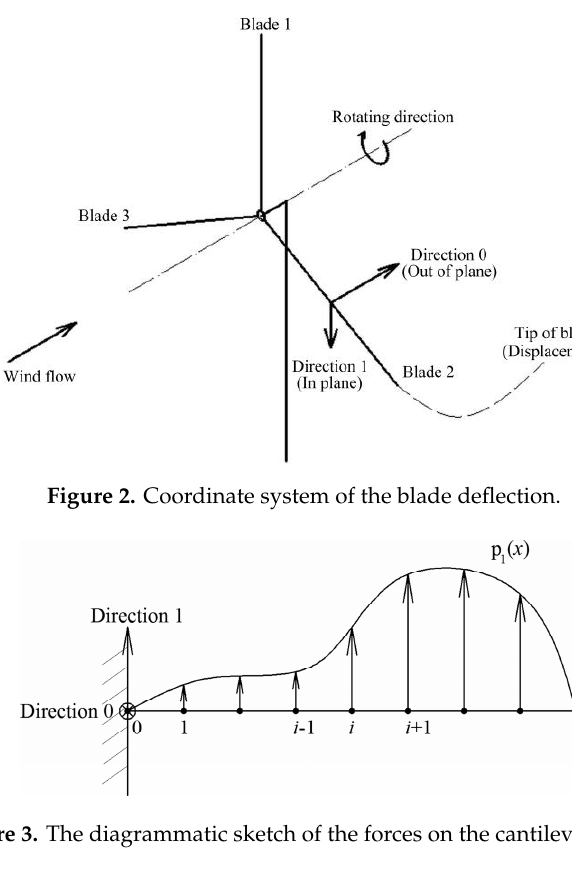
Figure 4. The blade element in the local coordinate system. 2.3. New Elastic Actuator Line Model In this section, the ALM is improved into a new elastic actuator line model (EALM) based on turbinesFoam library, which is developed by Bachant et al. [25]. This library uses ALM to simulate wind and marine hydrokinetic turbines in OpenFOAM. Its interpolation, Gaussian projection, and vector rotation functions are all adapted from NREL’s Simulator for Off/Onshore Wind Farm Applications (SOWFA). In EALM, the body forces are calculated by traditional ALM and the blade deflection is computed by rotating beam solver, which is defined in Section 2.2. The computation process of EALM is given in Figure 5, in which the difference between EALM and ALM is marked by dashed rectangle. The part of structure solver is added into the actuatorLineSource class, and the actuator point is changed in the actuatorLineElement class. From Figure 5, it can be found that this combination of ALM and structure model is one-way coupling. Compared with the research by Meng et al. [23], the part of aerodynamics solver is similar, but the way of dealing with structural solver is different (see Section 2.2). The advantages of this model are that the EALM allows large time step when the position of actuator line changes every time and computes long terms of wind